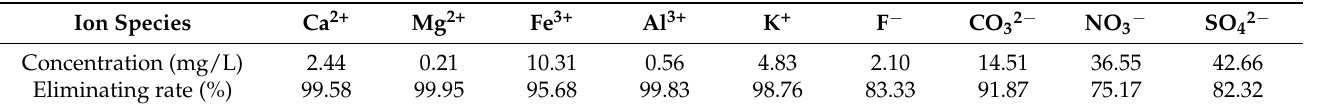
Table 4. Coexisting ions and organic matter in the desorption solution and the corresponding elimination rate.